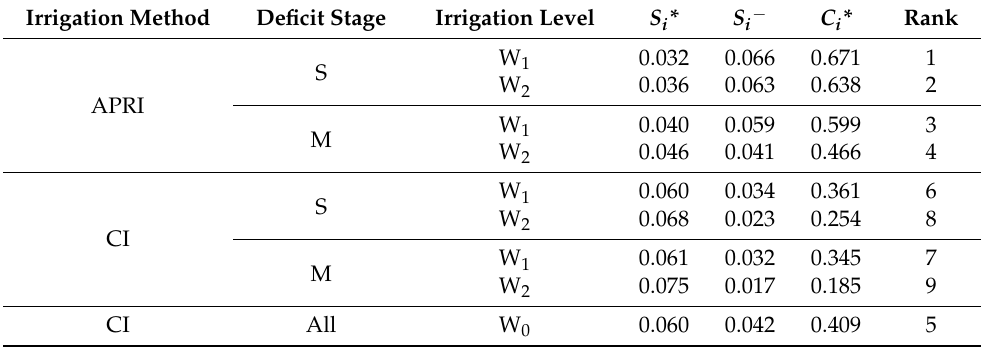
Table 6. The Euclidean distances S i * and S i − between each target value and the ideal point and the relative closeness C i * of each